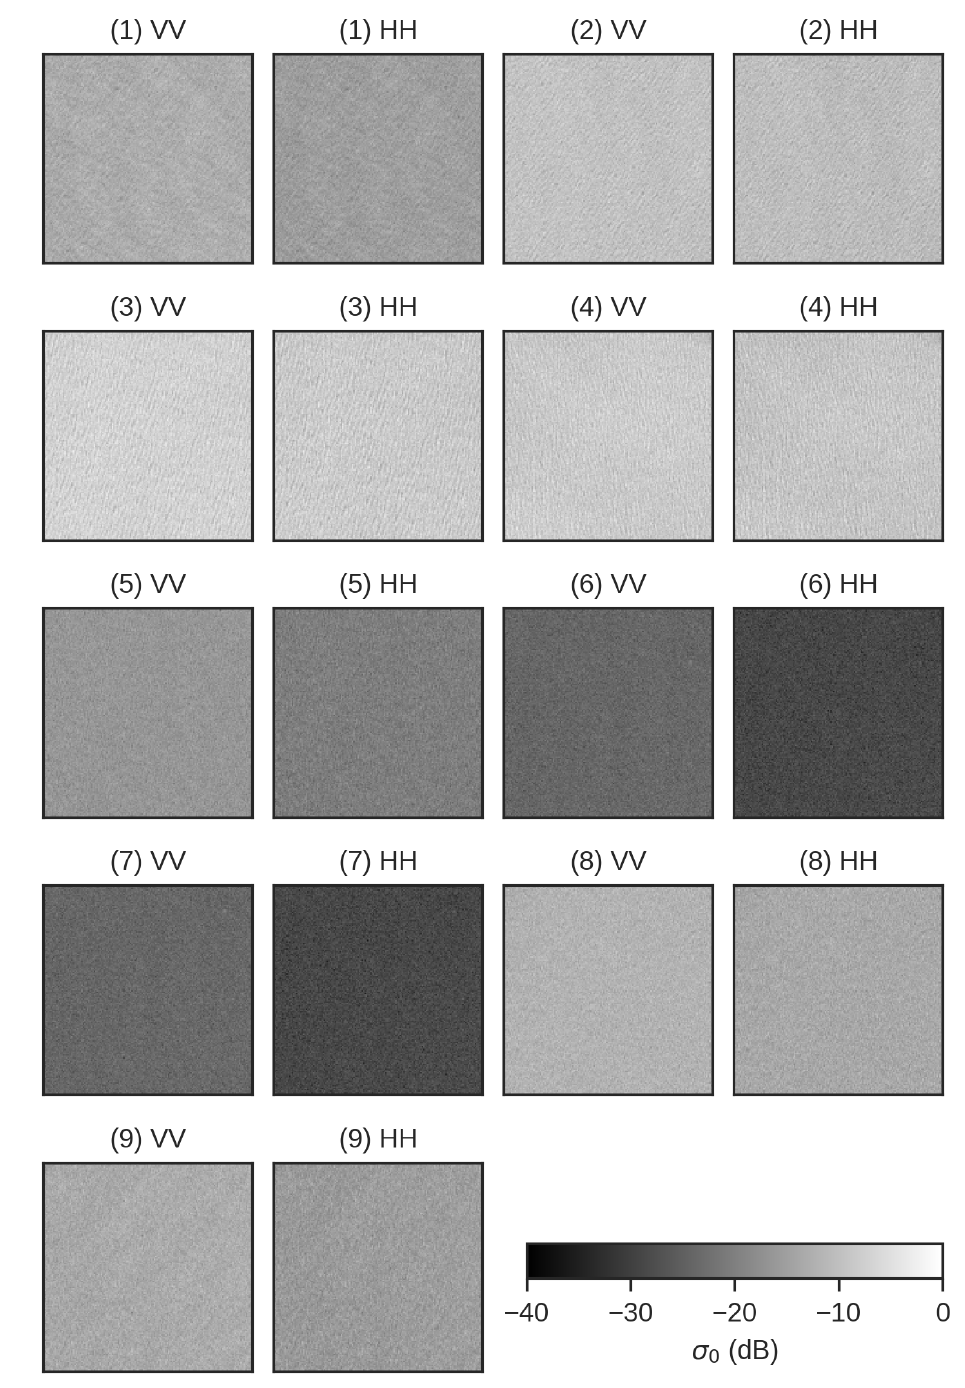
Figure 2. RadarSAT-2 dataset. VV- and HH-polarized intensity images (size: 150 × 150 pixels, spatial resolution: 50 m), in dB, over clean-sea surface area. Numbers refer to ID of each scene as shown in Table